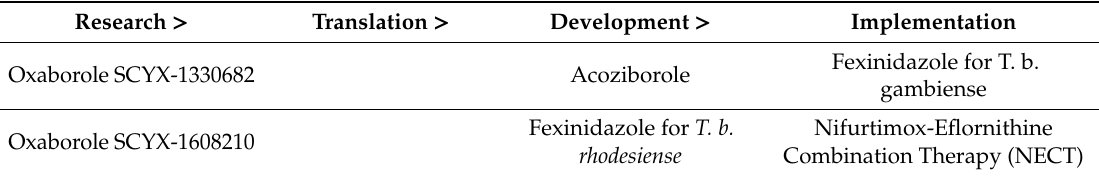
Table 1. DNDi’s HAT